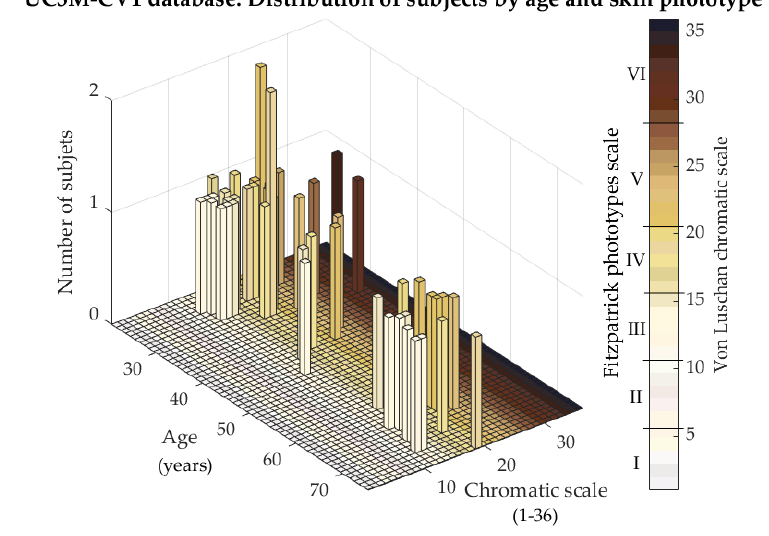
Figure 9. UC3M-CV1: Distribution of subject by age and skin phototype, according to the Fitzpatrick phototypes scale and the von Luschan chromatic scale.